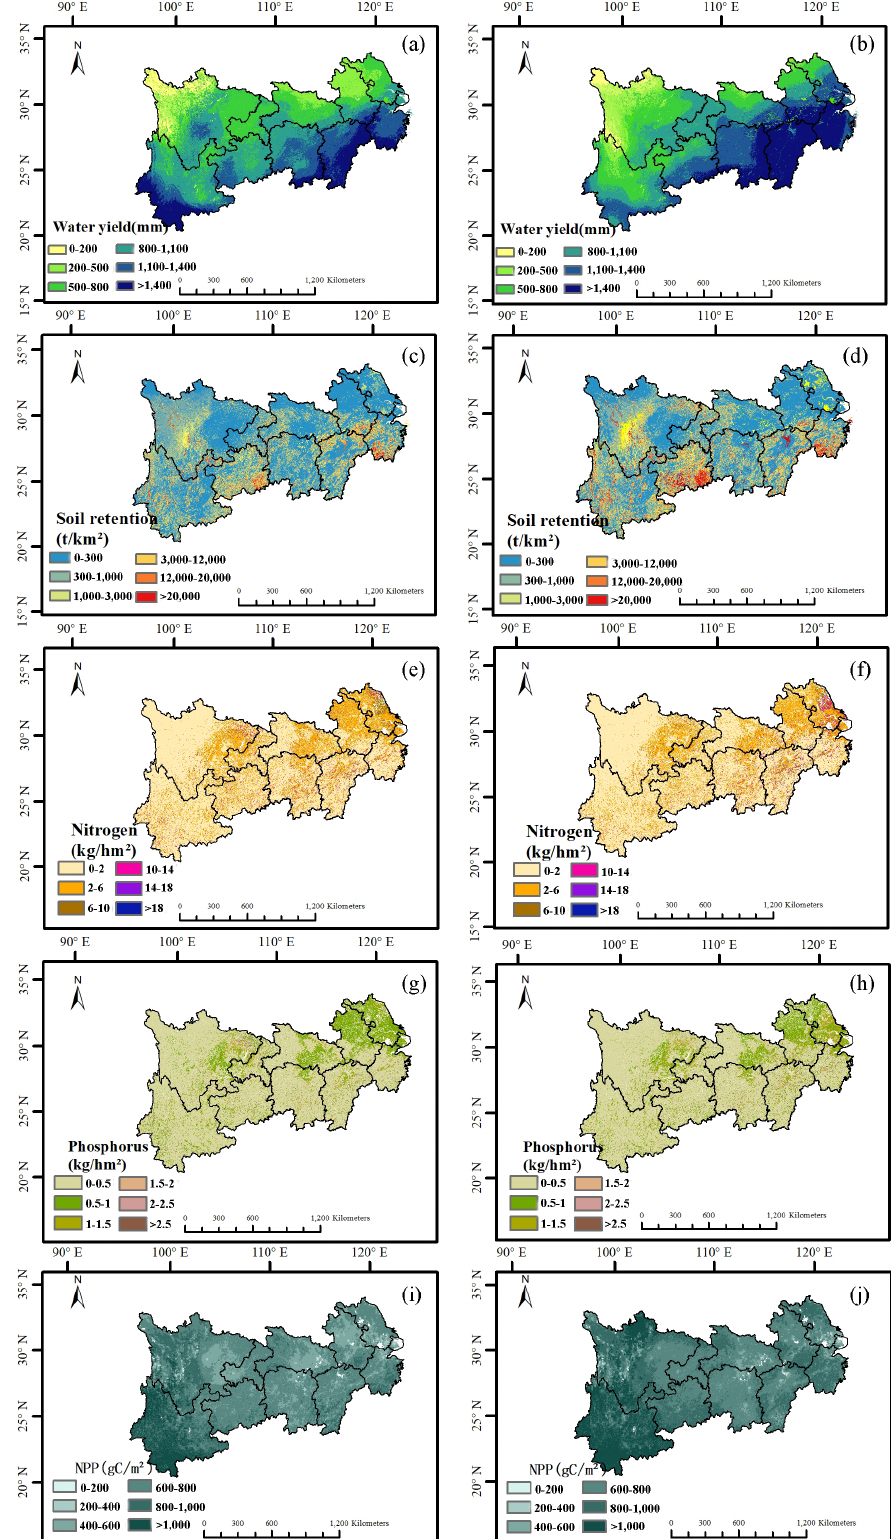
Figure 5. Spatial characteristics of ESs in the YREB from 1999 to 2018 (during 1999–2008: ( a ). water yield, ( c ). soil retention, ( e ). total nitrogen, ( g ). total phosphorous, and ( i ). NPP; during 2009–2018: ( b ). water yield, ( d ). soil retention, ( f ). total nitrogen, ( h ). total phosphorous, and ( j ). NPP).